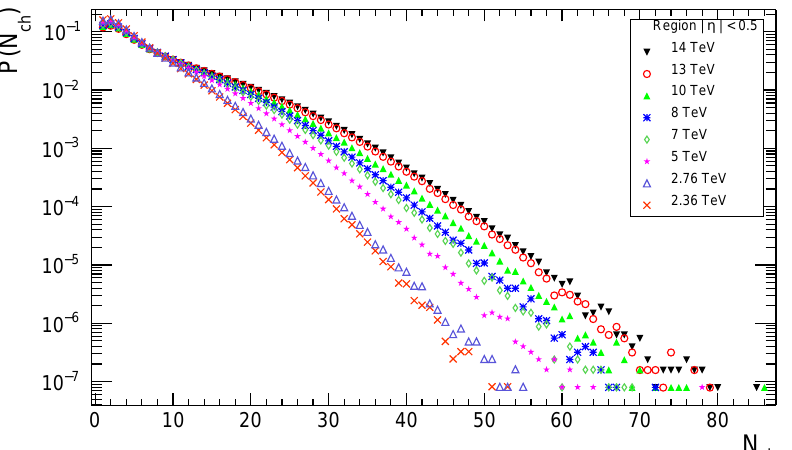
Figure 1. The charged particle multiplicity distribution in the pseudorapidity interval | η | < 0.5, with p T > 0.1 .